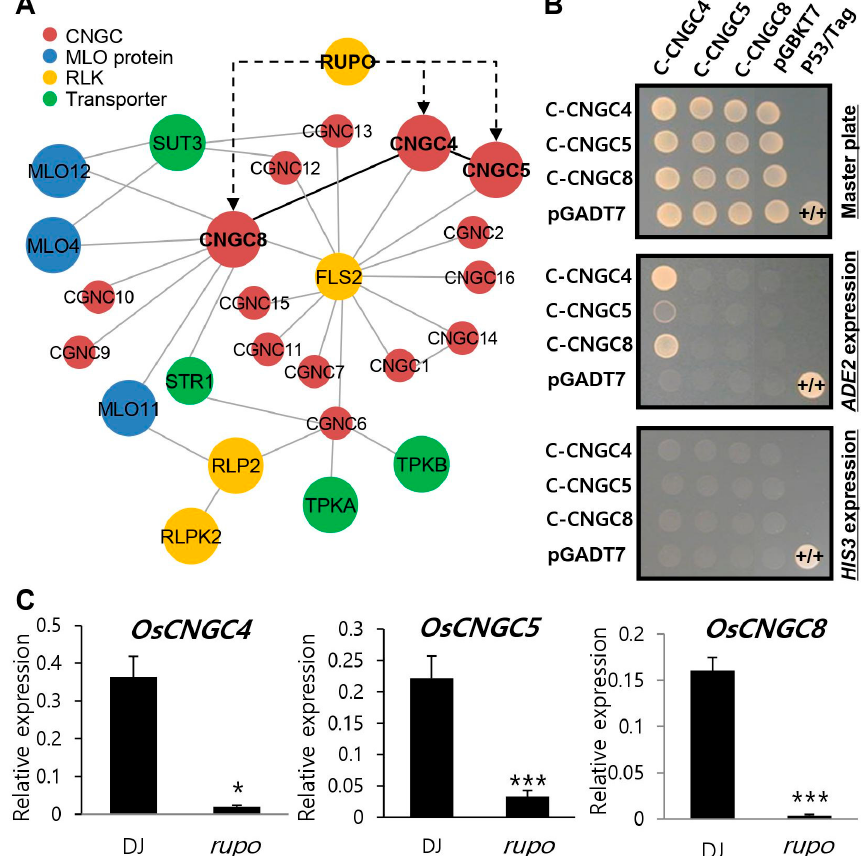
Figure 6. ( A ) The CNGCs network was drawn based on string database and yeast two-hybrid interaction data in this study. Red circles indicate OsCNGC proteins; blue circles indicate MLO proteins; yellow circles indicate RLKs (receptor-like-kinases); green circles indicate transporter proteins. Bold letters indicate OsCNGC with pollen-preferred expression. Black edges indicate physical interactions; gray edges indicate reference-based interaction; the dotted lines indicate indirect regulation. ( B ) C-CNGC4, C-CNGC5, and C-CNGC8. C-CNGC4, C-terminal region of OsCNGC4 from 552 aa to the end; C-CNGC5, C-terminal region of OsCNGC5 from 581 aa to the end; C-CNGC8, C-terminal region of OsCNGC8 from 430 aa to the end. AH109 yeast transformants were dropped onto selective medium lacking Leu and Trp (SD-LW) or also lacking Ade (SD-LWA) or Ade and His (SD-LWAH), with or without 5 mM 3-amino-1,2,3-triazole (3-AT), a competitive inhibitor of yeast HIS3. Positive control, yeast transformed with the P53 bait plasmid and the Tag prey plasmid. Negative control, yeast transformed with the parental bait vector (pGBKT7) and the prey vector (pGADT7). ( C ) Relative expression of pollen-preferred OsCNGC genes between DJ (wild-type rice) and knockout rupo mutant. Rice ubiquitin 5 ( OsUbi5, LOC_Os01g22490 ) was used as an internal control. Error bars represent the standard errors of three biological replicates. Significant differences are indicated by asterisks, * p < 0.05. *** p < 0.001.